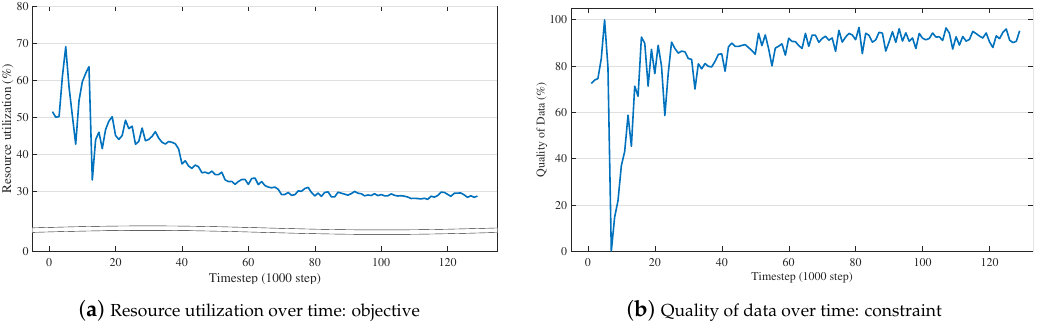
Figure 21. Variant objective test: LA3 for this test aims at minimizing the number of sensor data updates (so, reducing the resource utilization ( a )) while satisfying a given QoD requirement (e.g., 95% ( b